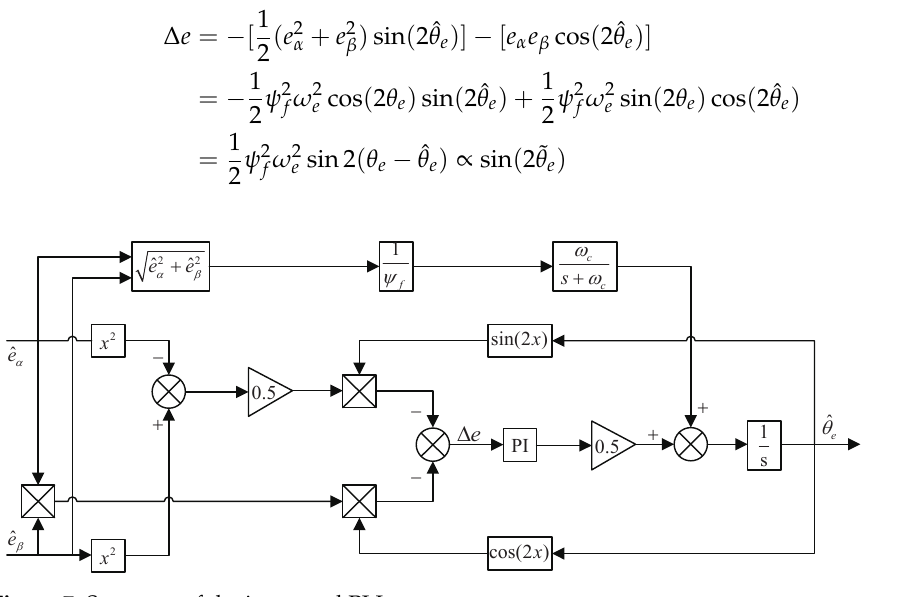
Figure 7. Structure of the improved